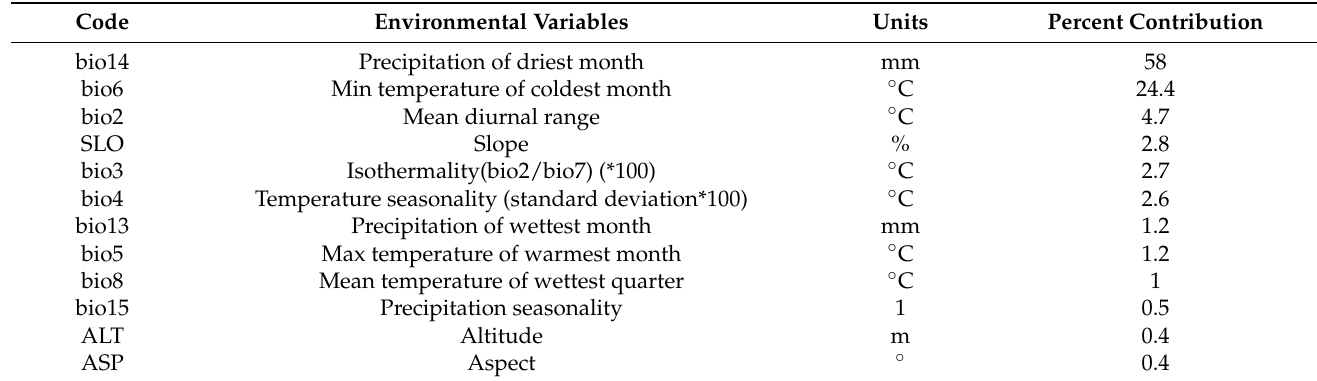
Table 1. Permutation importance of variables for modeling.